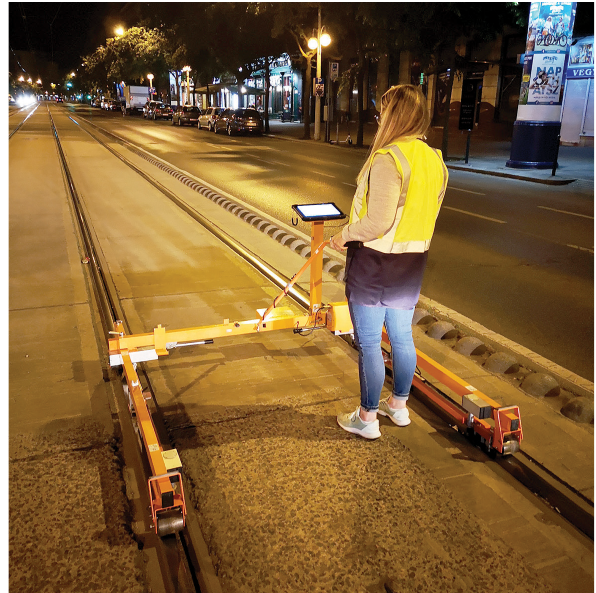
Figure 15. Geometrical measurement in Budapest (authors’